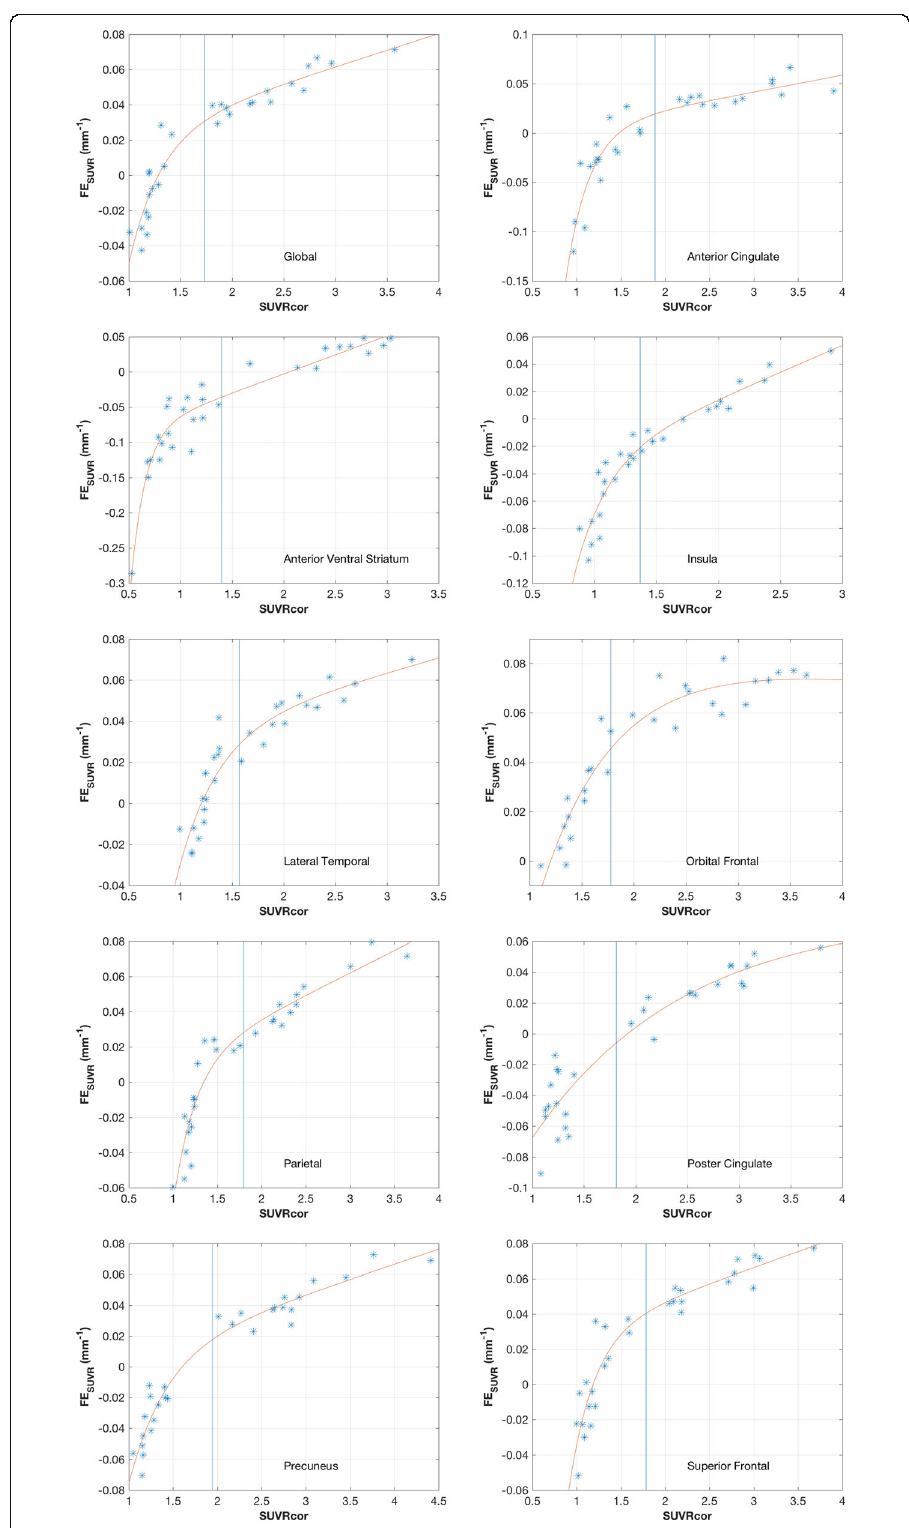
Fig. 3 (See legend on next